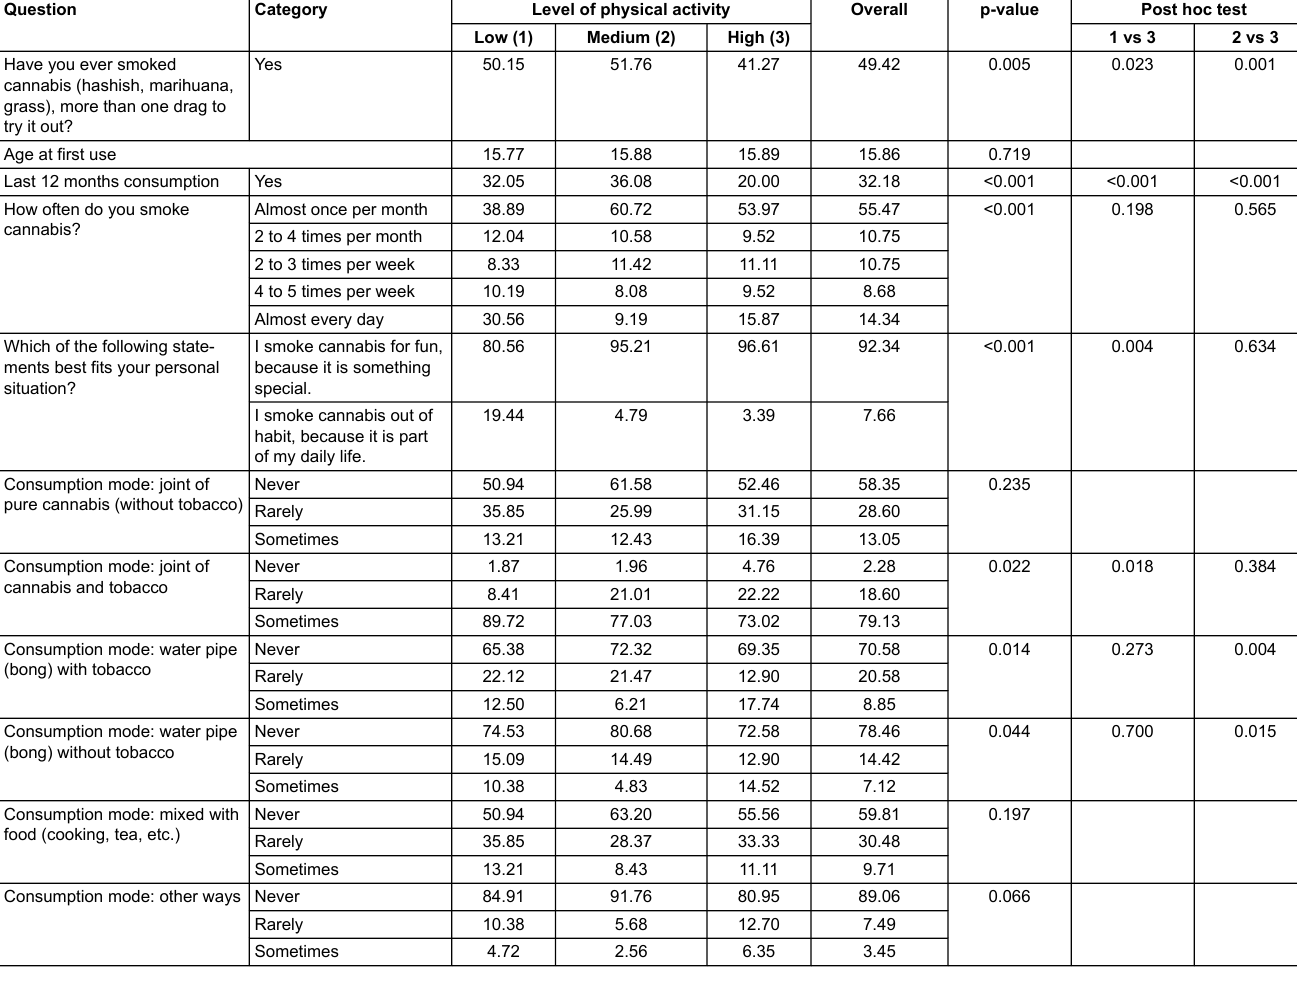
Table 6: Cannabis consumption by level of physical activity.